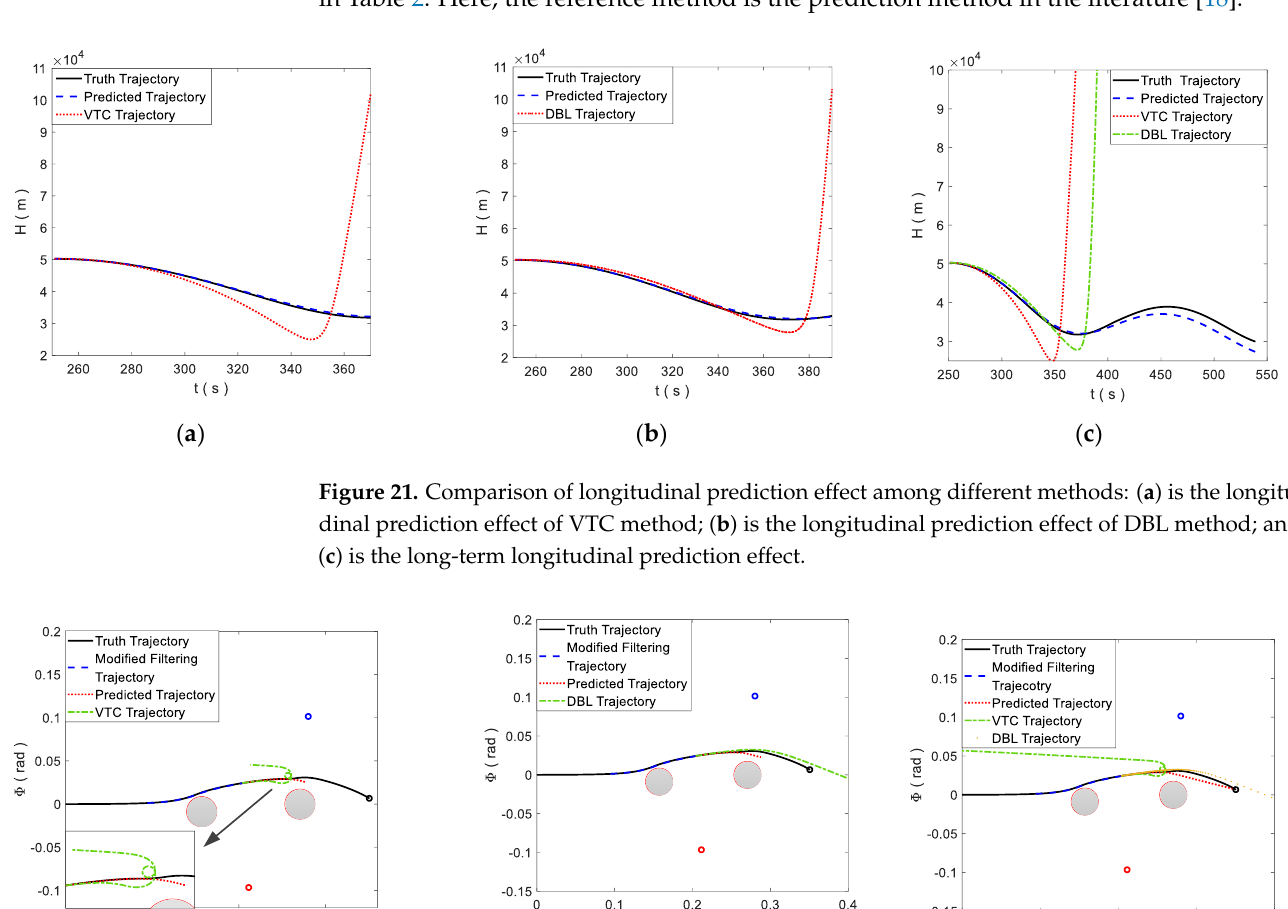
( b ) Figure 20. Prediction effect comparison among different methods: (a) represents the short-term longitudinal prediction trajectory; and (b) represents the short-term lateral prediction trajectory.